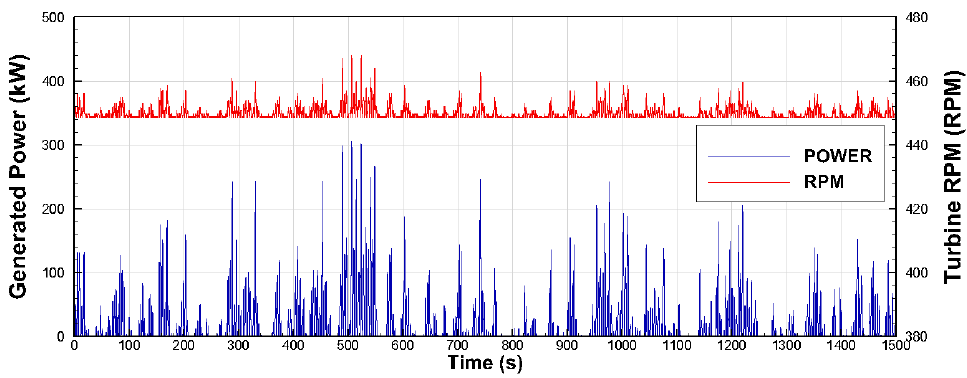
Figure 3. Generated power and generator revolution per minute (RPM) data obtained from Yongsoo OWC pilot plant.